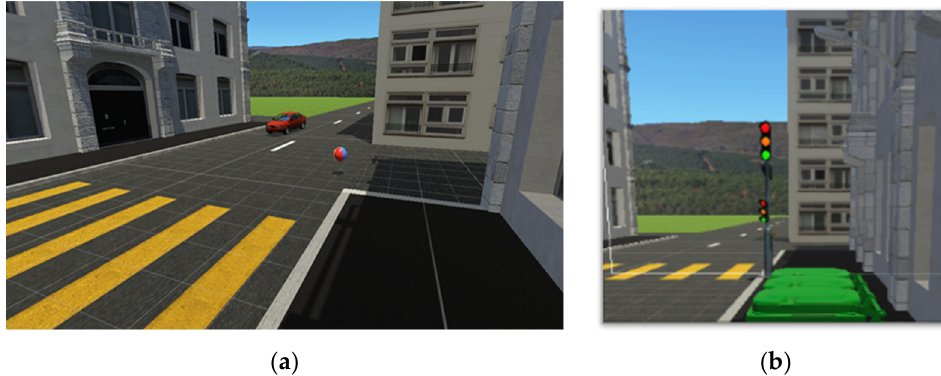
Figure 3. Crosswalk and moving in the street scenario. ( a ) Unprotected crosswalk with a ball crossing the street (distraction) and ( b ) protected crosswalk with contingencies (trash can in the middle of the pavement).